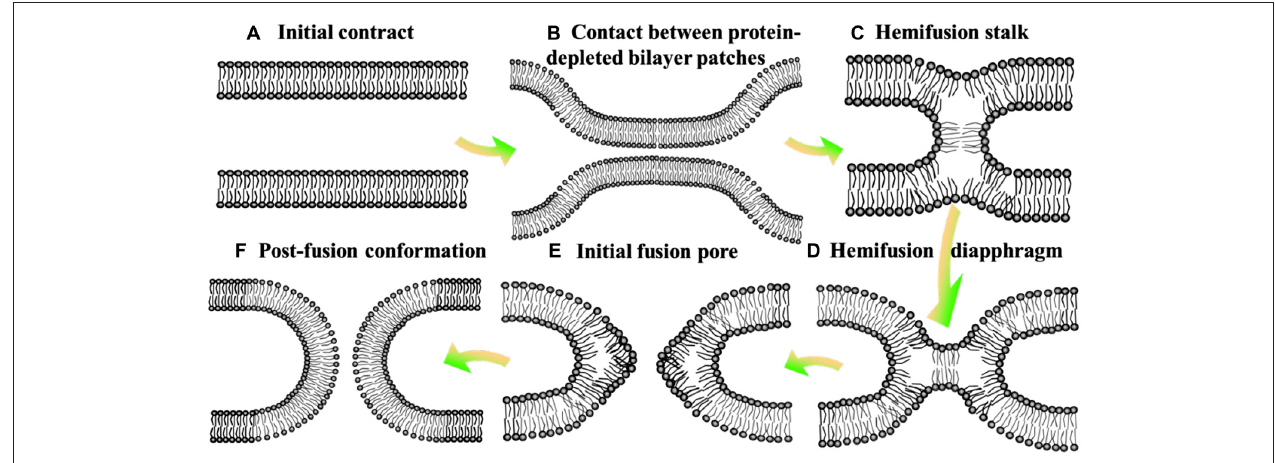
FIGURE 1 | Hemifusion intermediate during the process of membrane fusion. At the state of initial contact (A) , lipid bilayers move apart to allow local close contact between two membrane bilayers which proteins mediate membrane binding and fusion (B) and a merger of their contacting leaflets into a stalk like hemifusion connection (C) that expands into a small hemifusion diaphragm (D) . An initial fusion pore opens in a HD (E) . This pore gives rise to an hourglass fusion pore (F) , expansion of which completes the fusion reaction. There show the bilayer surfaces formed by lipid polar